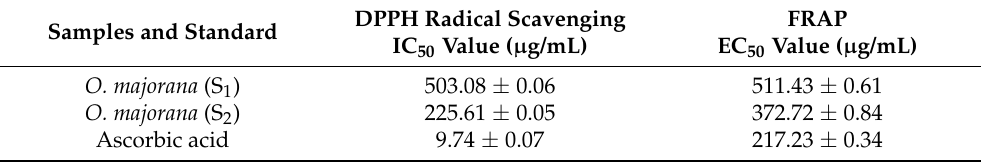
Table 5. Antioxidant activity of O. majorna EOs (S 1 and S 2 ) and ascorbic acid (standard). Samples and Standard